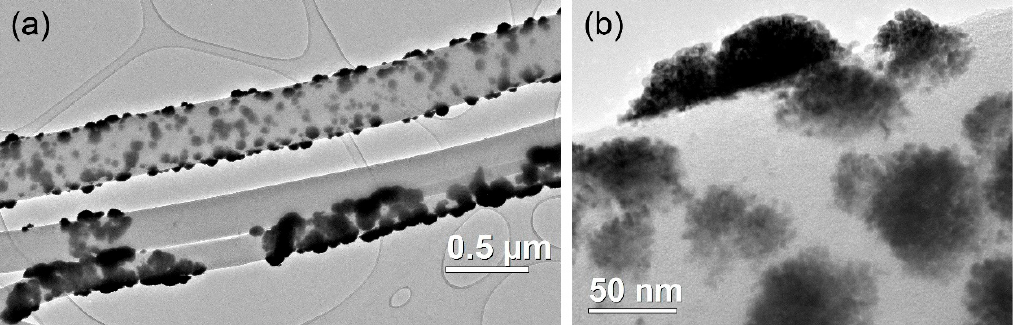
Figure 1. ( a ) BF TEM images of Pt on a CNF with smooth surface ( b ) enlarged image of Pt agglom- erated nanoparticles for sample 1 .